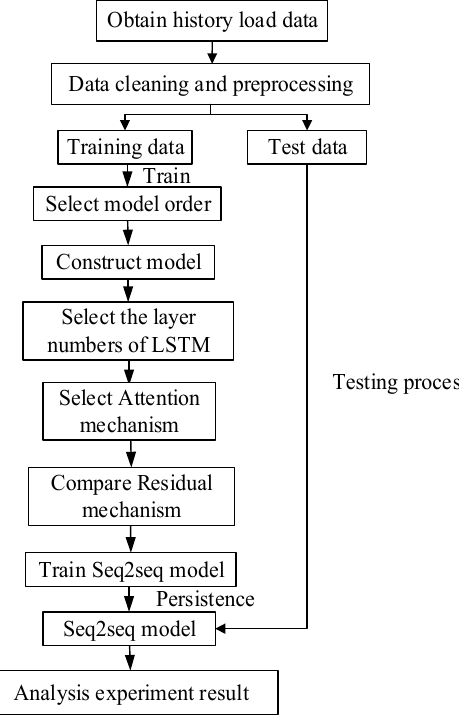
Figure 5. Short-term load forecasting flowchart.